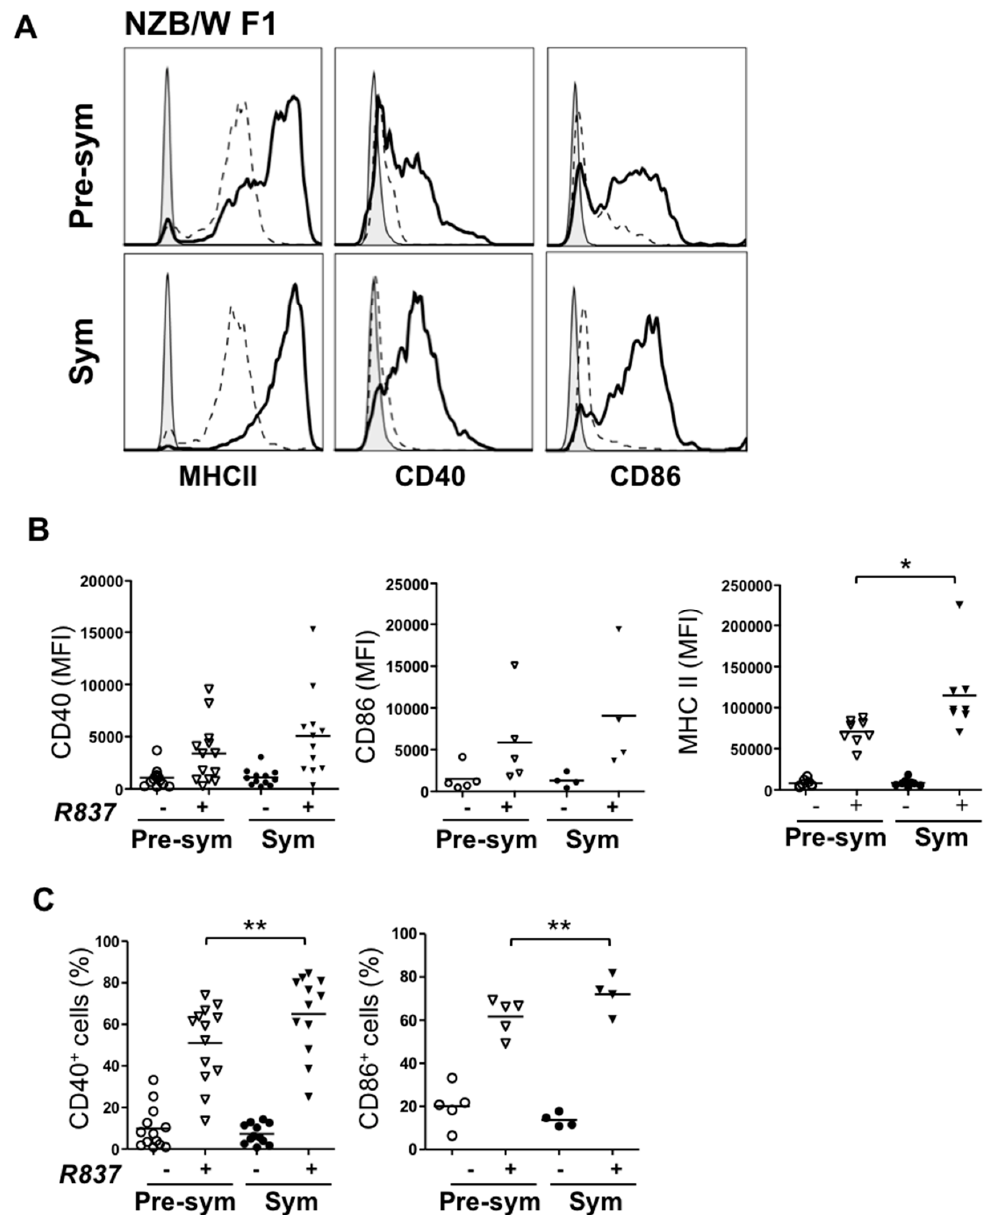
Figure 3. pDCs response to TLR7 stimulation is augmented in symptomatic mice. Purified BM-derived pDCs from pre-symptomatic (Pre-sym) or symptomatic (Sym) NZB/W F1 mice were treated with (+) or without ( − ) 5 µg/mL of R837 for 48 h. Expression of MHC class II, CD40 and CD86 were examined and shown as representative histograms in ( A ). Grey : Isotype; dotted line : unstimulated; solid line : R837 activated. Collective data illustrating changes in the mean fluorescence intensity (MFI) of MHC class II, CD40 and CD86 or percentages (%) of the latter two are shown in ( B , C ) respectively. Each symbol represents one experimental mouse. For expression of CD40, n = 12–13; CD86, n = 4–5; MHC class II, n = 8. Data were collected from at least three independent experiments. Bar: mean value. * p ≤ 0.05; ** p ≤ 0.01; (unpaired two-tailed Student’s t -test).